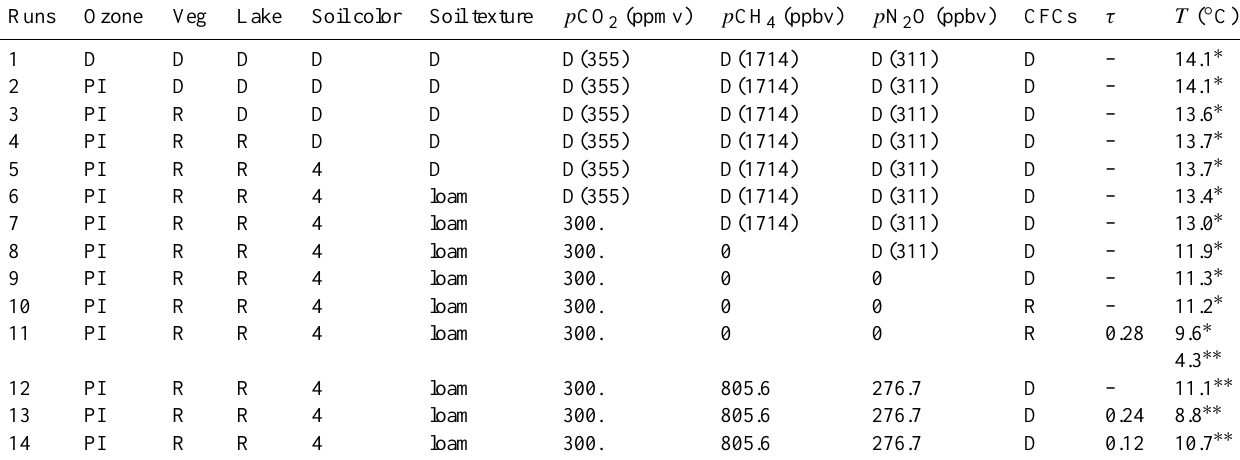
Table 1. Summary of runs carried out with the present-day continental configuration in order to test the influence of variable changes. Variable “ τ ” is the optical depth of aerosols. Characters “D”, “PI”, “R”, and “–” stand for “default”, “pre-industrial”, “removed”, and “not applicable”, respectively, where the default value (in the brackets) may follow the character “D”. “ T ” is resulting 10yr mean global mean surface temperature at the end of simulations (either 100 yr or 2000 yr).